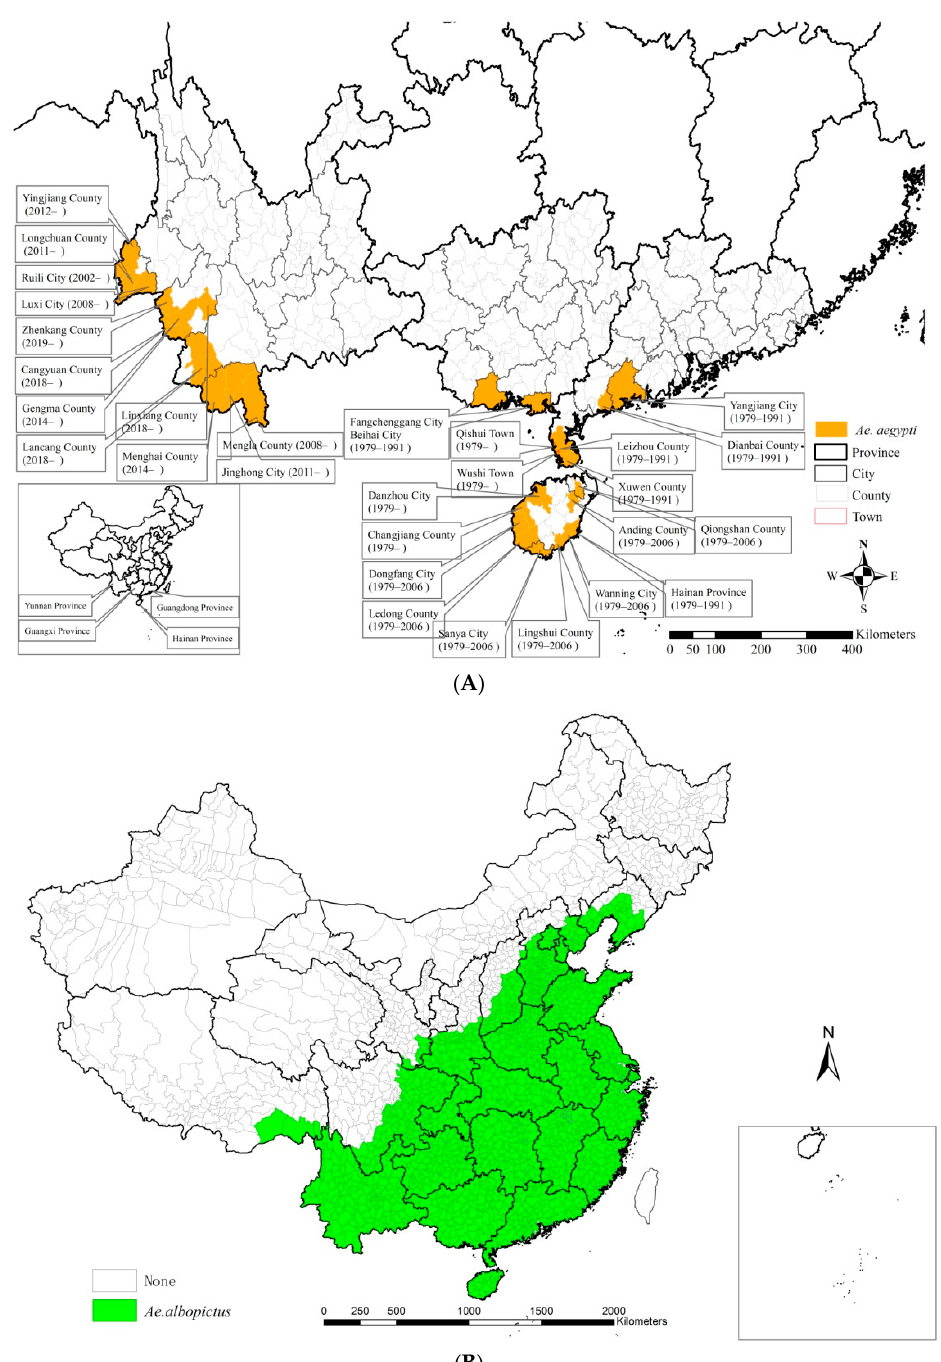
Figure 6. Spatial distributions of Aedes in mainland China. ( A ) Aedes aegypti . ( B ) Aedes albopictus.